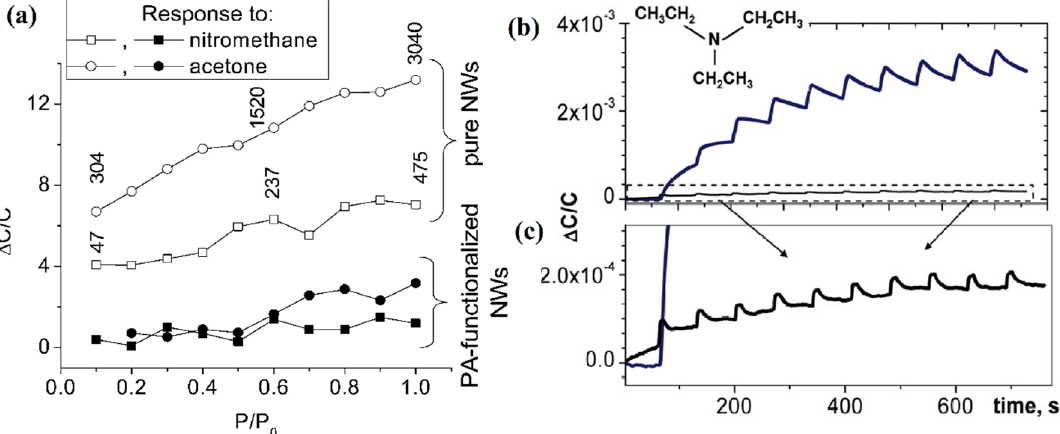
Figure 16. Graphs showing response of gallium oxide nanowires and PA adsorbed gallium oxide nanowires. The reduction in the ppm of nitromethane and acetone is clearly visible. ( a ) shows the Figure 15. The gas sensor made from Ga 2 O 3 nanowires [185]. “Reprinted with permission from Ref. response to TEA by pure nanowires and ( b , c ) shows the response by PA adsorbed nanowires.[187]. [185]. Copyright (2008), Elsevier.”. “Reprinted with permission from Ref. [187]. Copyright (2010), Elsevier.”.